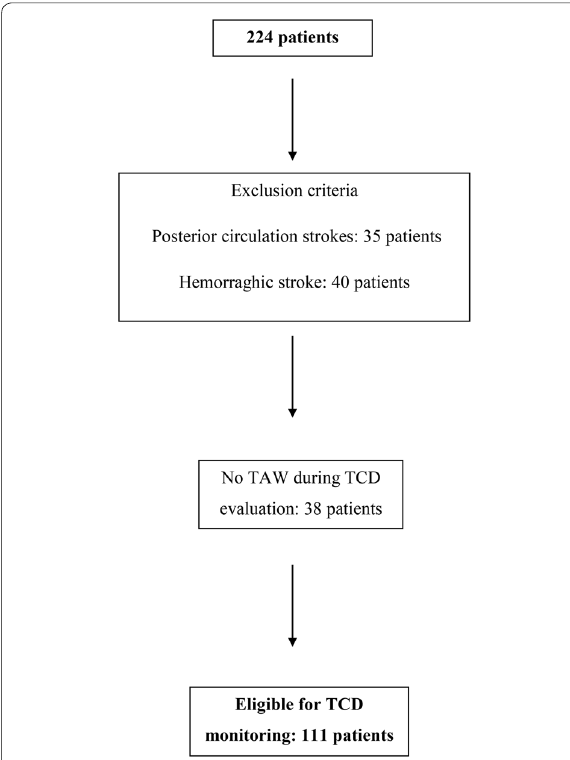
Fig. 2 Flow chart